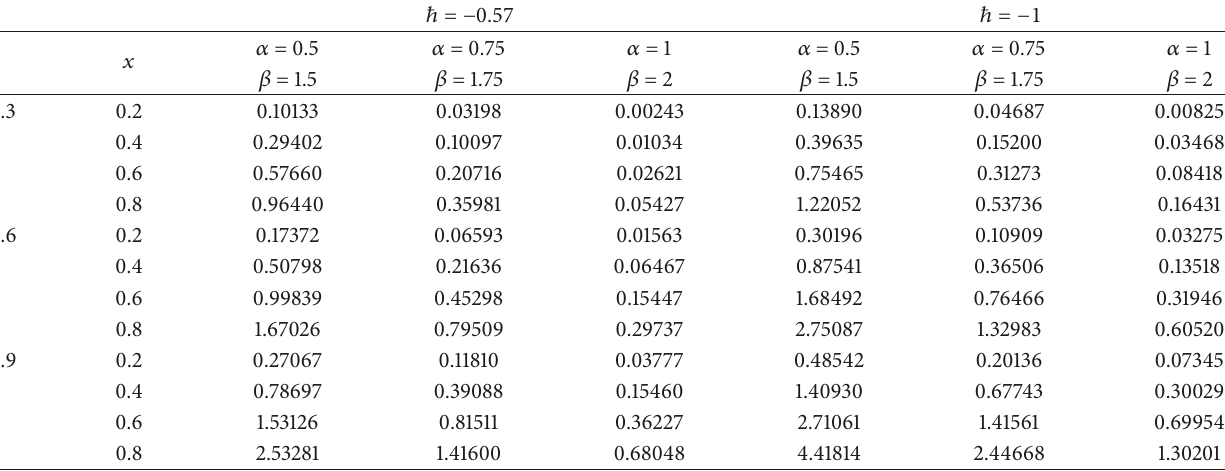
Table 4: The absolute errors for case B in Example